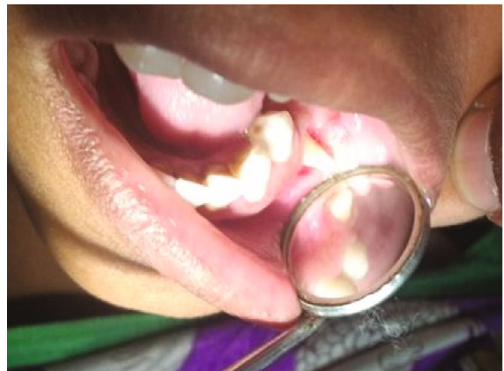
Figure 2: Clinical photograph showing the stretching of the cheek mucosa a tooth root found extruding from the socket impinging on the soft tissue counterpart surrounding areas.